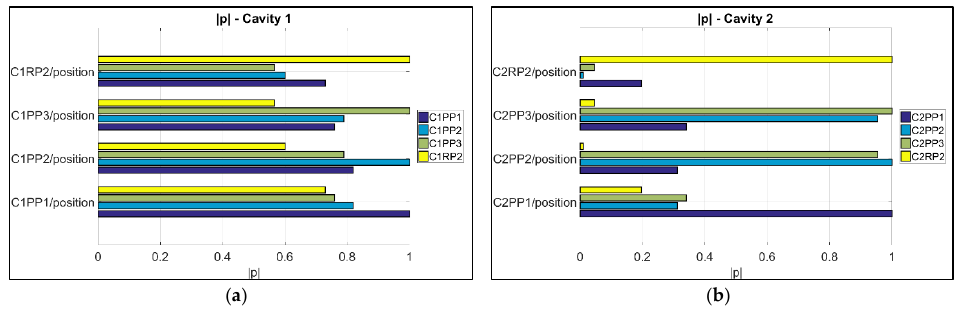
Figure 15. Pearson correlation coefficient plots of measurands to the pillar “product fingerprint” positioned on the runner of the molding ( a ) in Cavity 1 and ( b ) in Cavity 2. A perfect correlation | ρ | = 1 exists only for combinations of the same